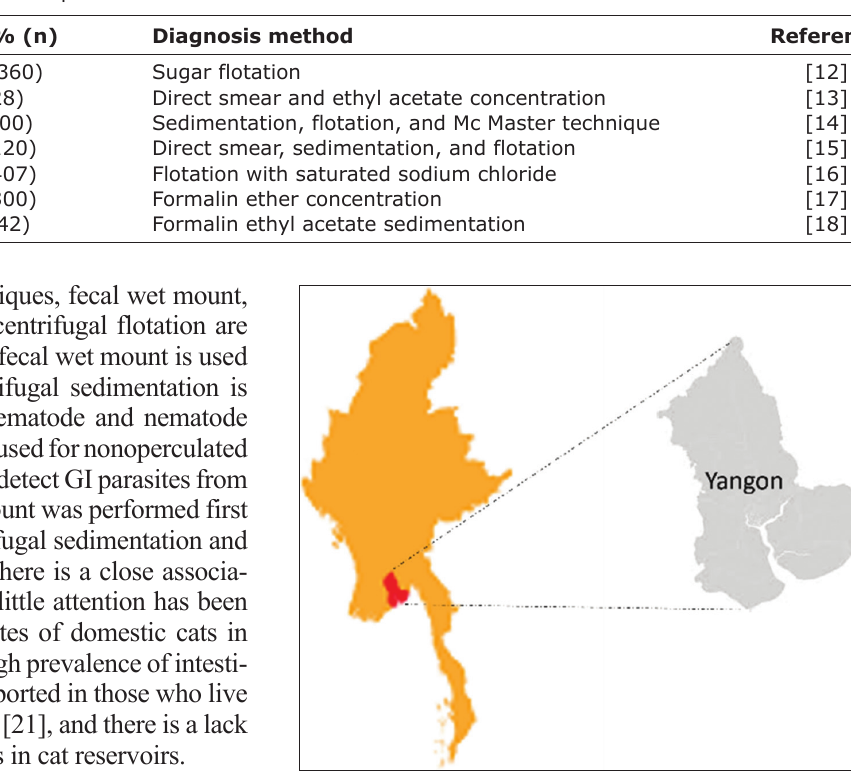
Table-1: Prevalence of gastrointestinal parasites in domestic cats from different countries.